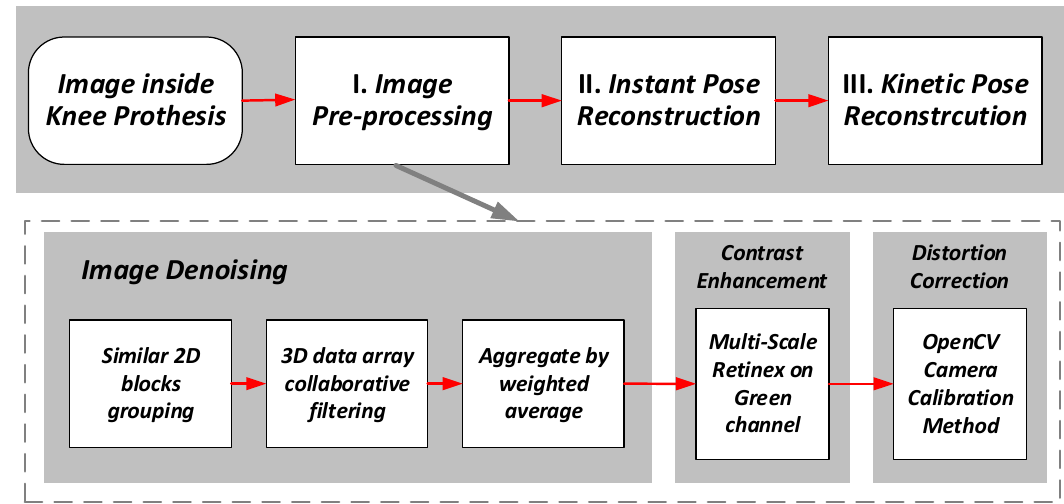
Figure 8. Data processing flow in the workstation.